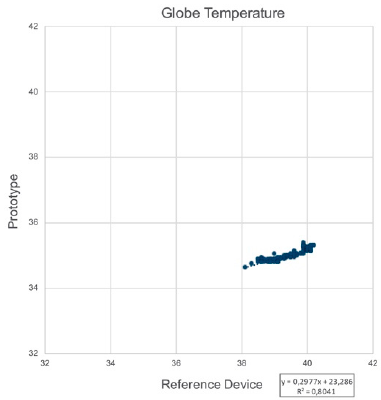
Figure 12. The linear regression graph for globe temperature.